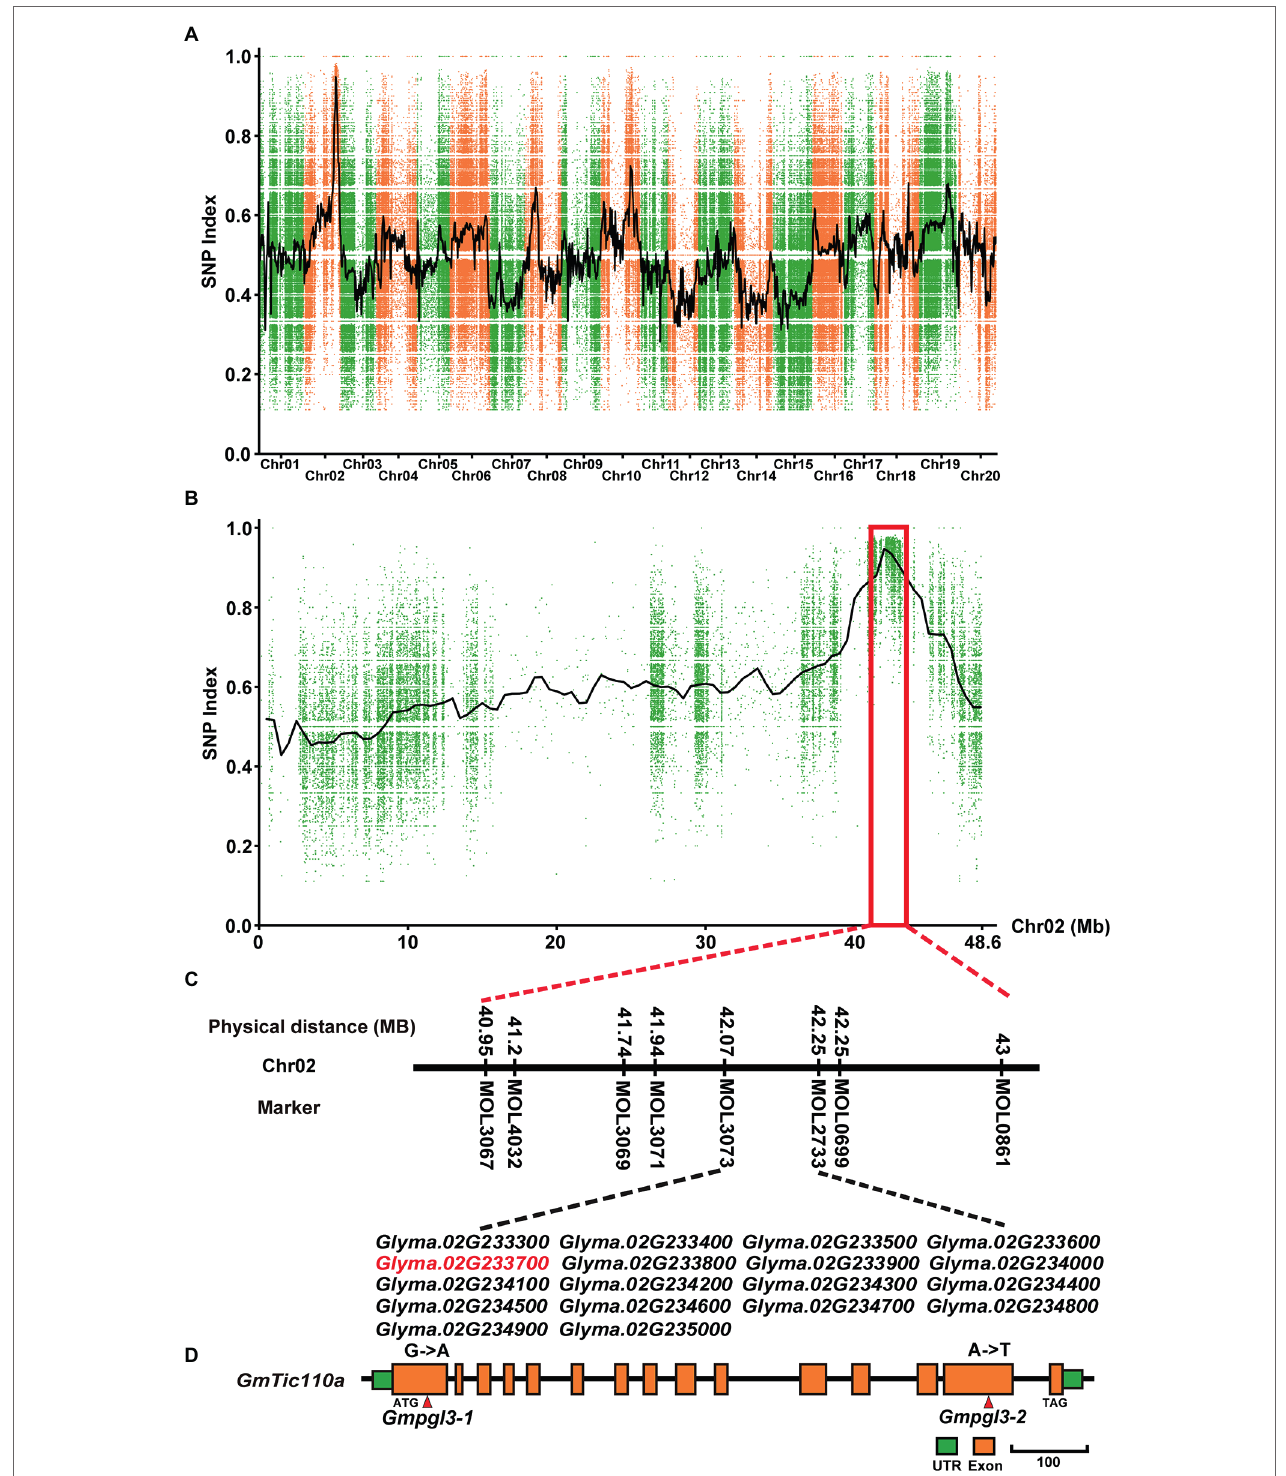
FIGURE 2 | Map-based cloning of the GmTic110a locus. (A) SNP index plot of all chromosomes of the F 2 plants. (B) SNP index plots of chromosome 02 of the Gmpgl3a mutant from the F 2 population. (C) Physical position of the GmTic110a candidate gene. (D) Schematic diagram showing the structure of GmTic110a . The red lines indicate mutation sites within the GmTic110a gene in the two mutant